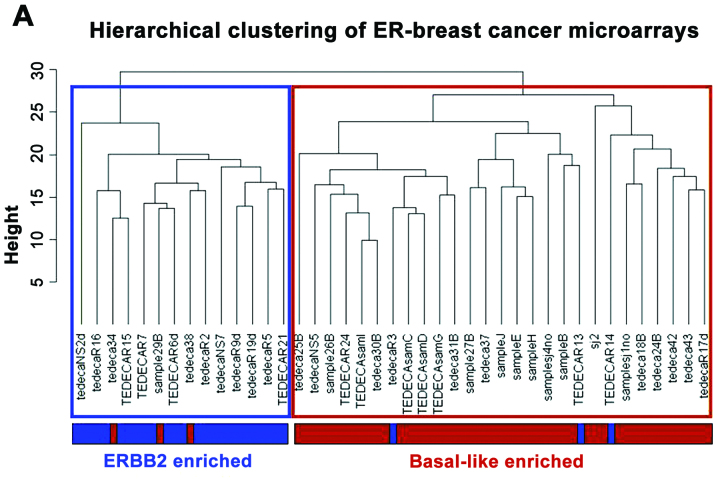
(A) Unsupervised hierarchical clustering (using euclidean distance metric and complete linkage) of the 41 samples from our ER− BC patients, showing the ERBB2-enriched and the basal-like enriched clusters. (B) Plot of the first 2 principal components in our ER− BC microarrays series.